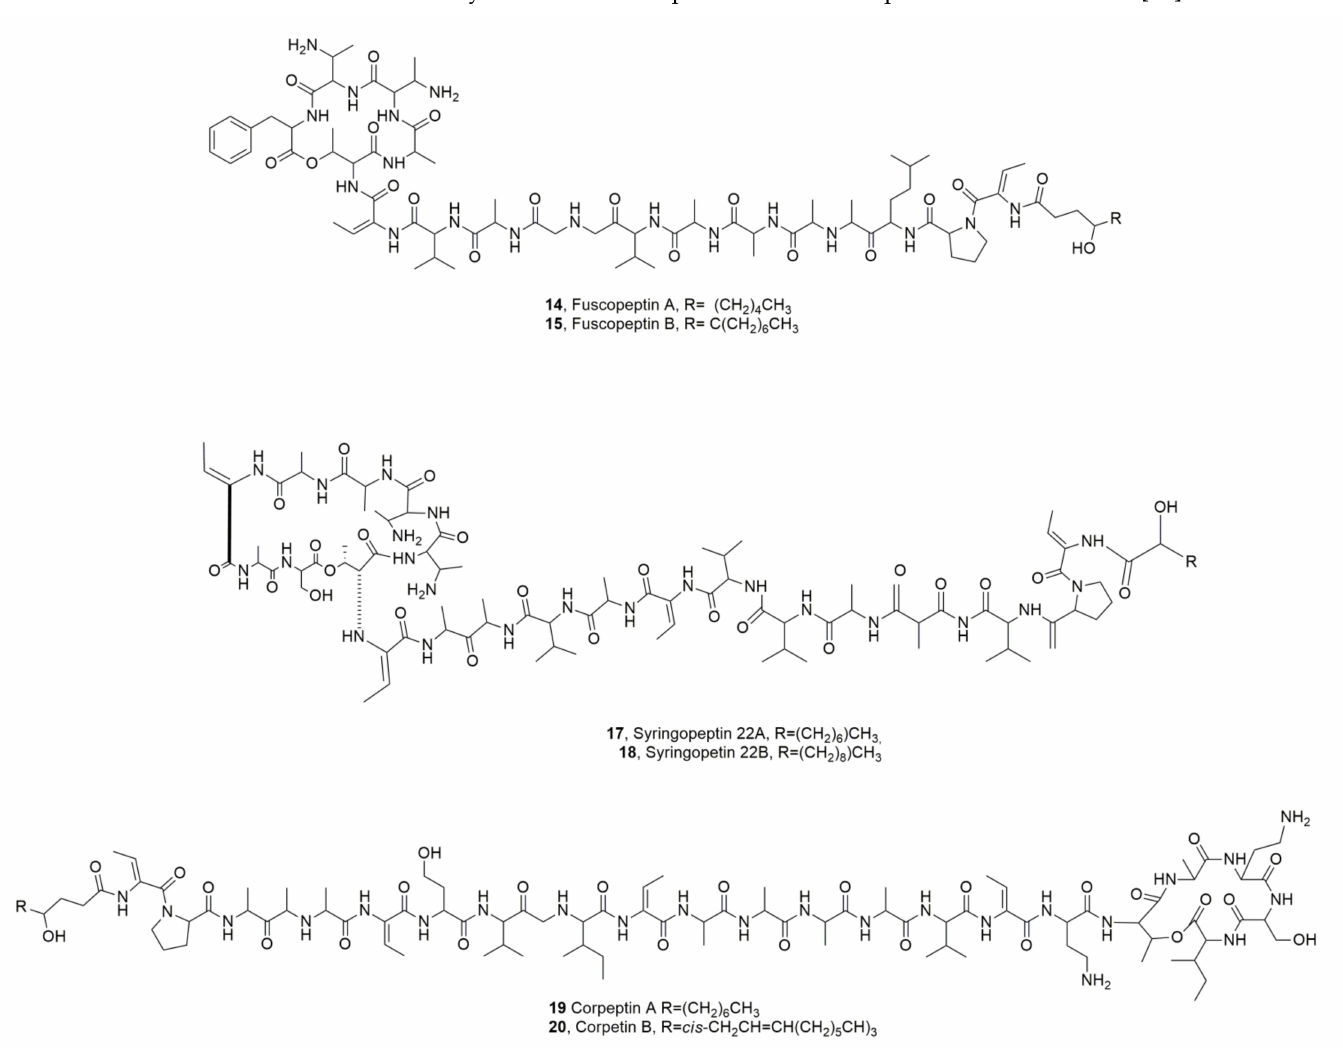
Figure 4. Lipodepsipeptides produced by Pseudomonas fuscovaginae ( 14 and 15 ), Pseudomonas syringae pv. syringae ( 17 and 18 ), and Pseudomonas corrugata ( 19 and 20